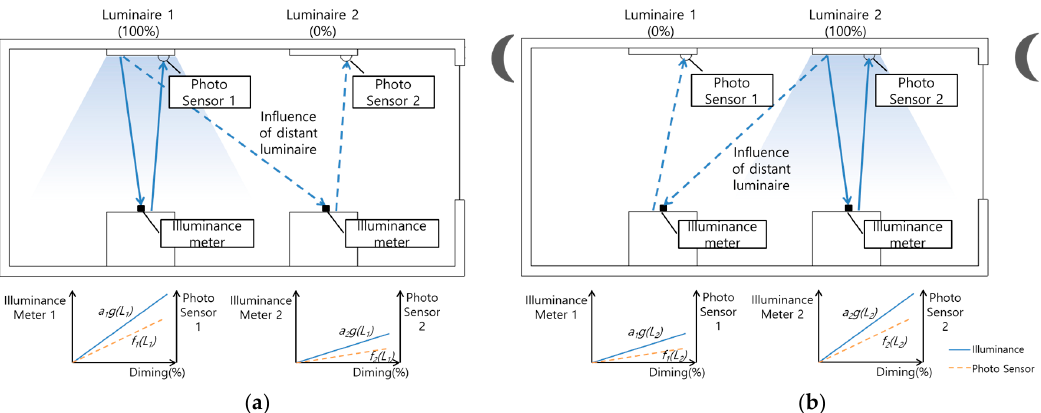
Figure 6. System processes of advanced commissioning: ( a ) learning process for luminaire 1; ( b ) learning process for luminaire 2.